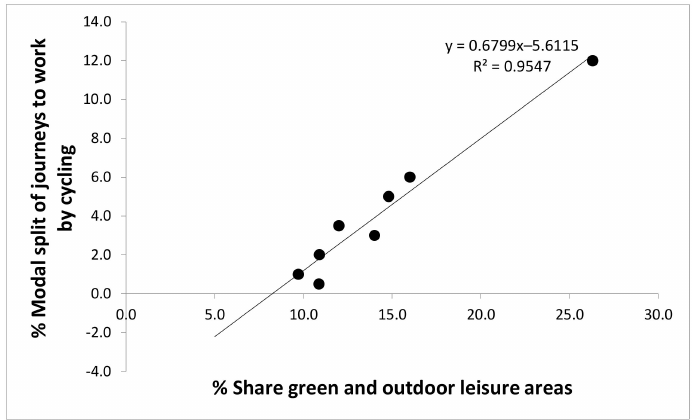
Figure 4. Linear regression between the percentage of green and outdoor leisure areas and the percentage of journeys to work by cycling in 8 of the selected